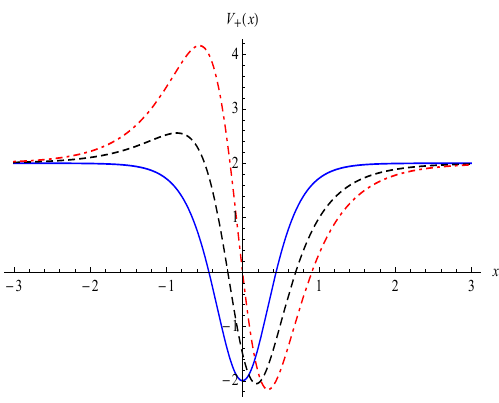
Figure 2 . Plot of the potential V + ( x ) for B = 0 (solid line), B = 0 : 5 (dashed line), and B = 1 (dotdashed line),